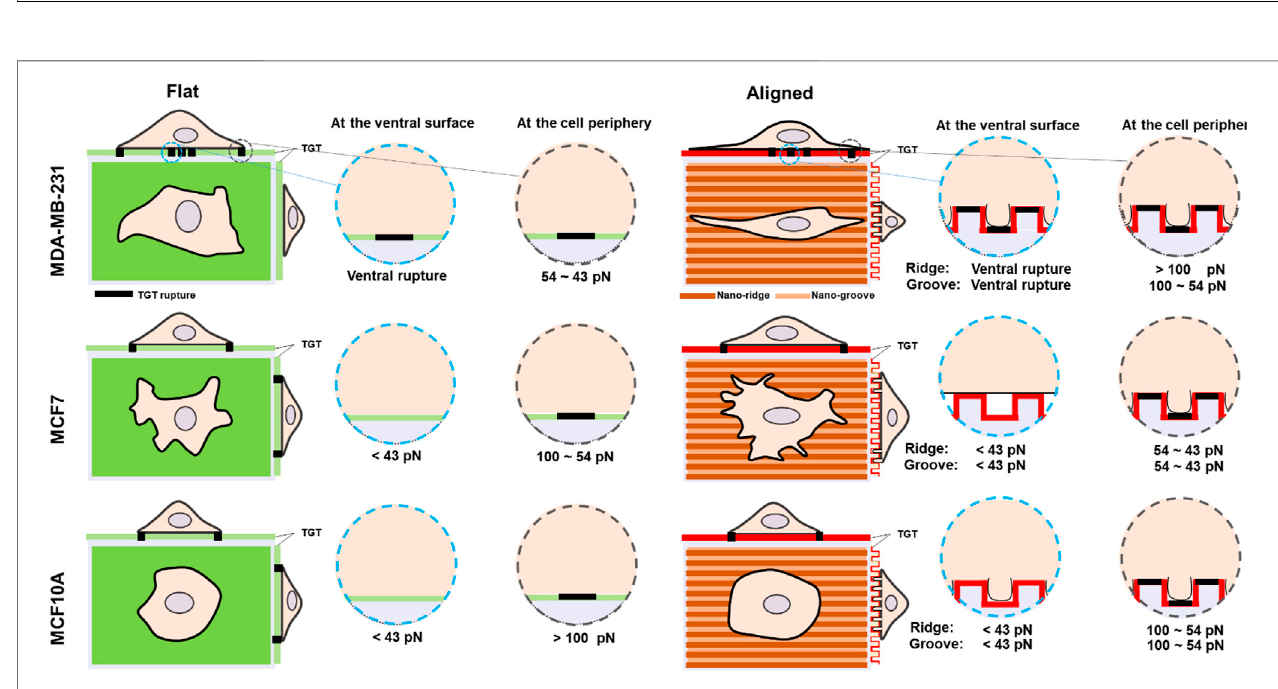
FIGURE 4 | Schematic comparison of molecular integrin tension exerted by three different human breast epithelial cells during adhesion and spreading on fl at and nanosurfaces.